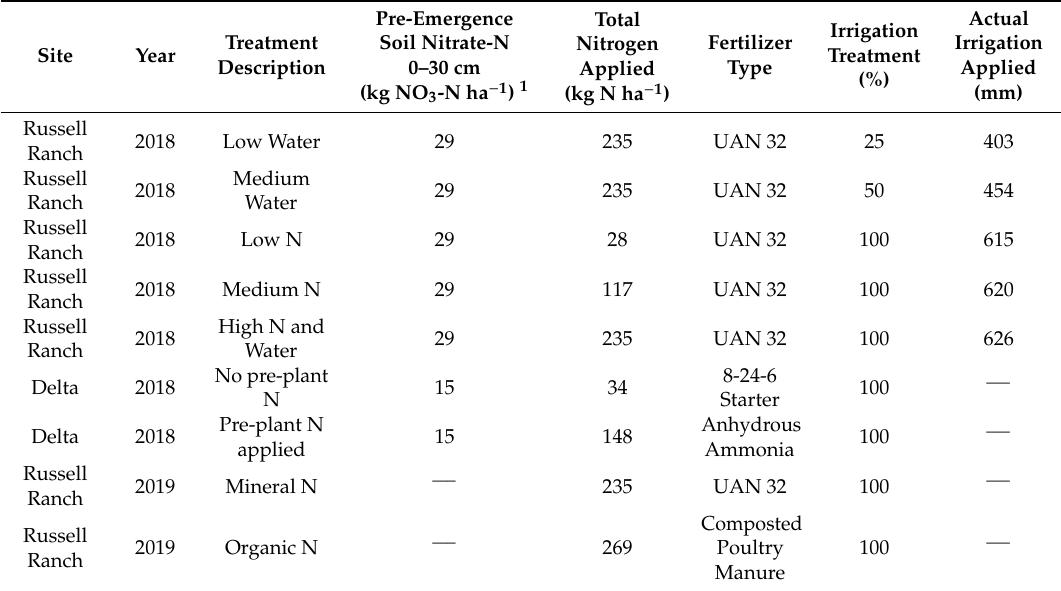
Table 1. A description of the applied nitrogen and irrigation treatments imposed at all sites included in this study.